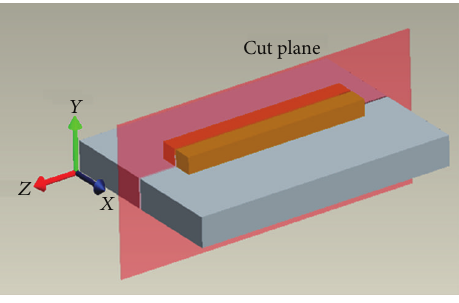
Figure 4: Substrate and clad geometry.